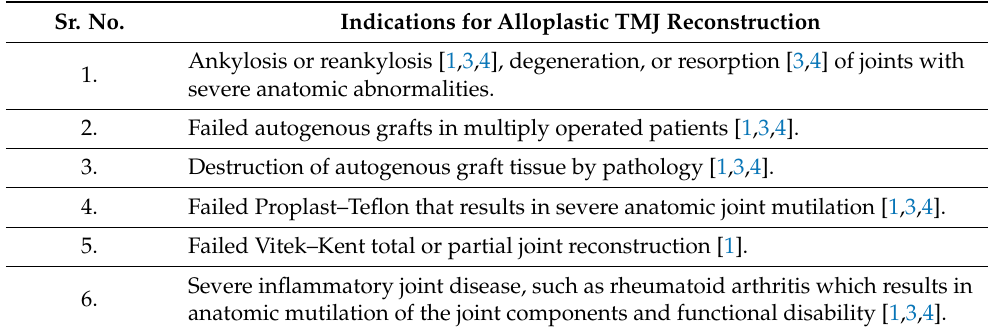
Table 1. Indications for the alloplastic reconstruction of the temporomandibular joint (TMJ). Sr.